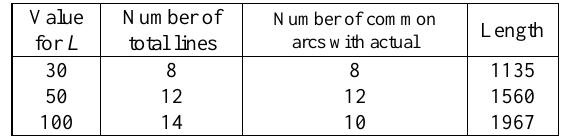
Table 4. Results obtained from different values for L